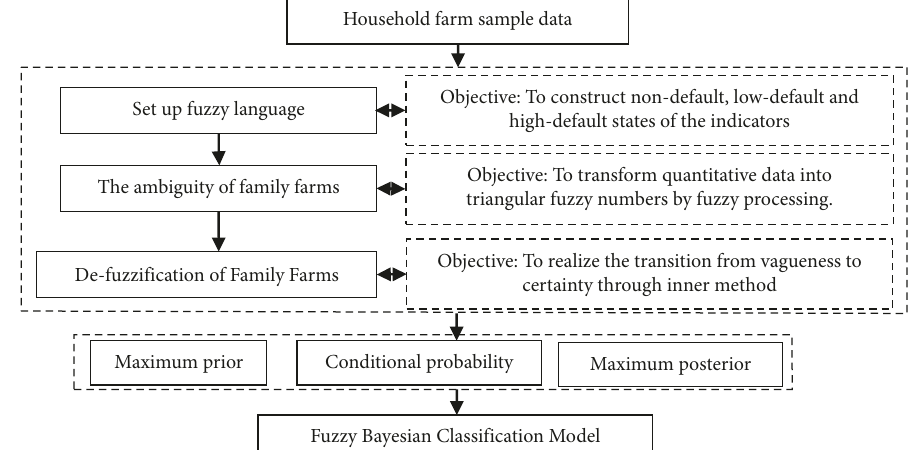
Figure 1: Principle for solving difficulty one.